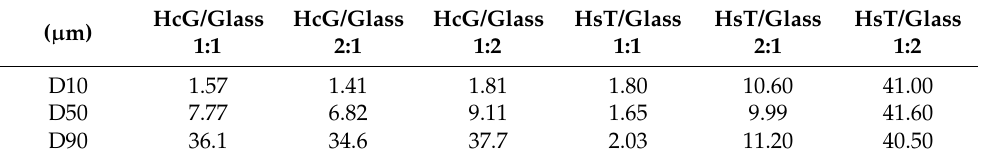
Figure 1. Volumedensitycurvesoftheparticle-sizedistributionsofthedifferentmixturesbylaser diffraction. The values of the particle sizes for the parameters D10, D50 and D90 are presented in Table 2, showing that all the mixtures presented a high fineness, because the D50 values were practically less than 10 µ m. In addition, a slight increase of fineness was observed in the HsT/Glass mixtures with regard to the HcG/glass mixtures and in the mixtures with larger quantities of glass (mix-proportion 1:2). Despite these minimum differences, the fineness had no effect on the reactivity of the pozzolan mixtures. Table 2. Values of D10, D50 and D90 ( µ m) obtained by laser